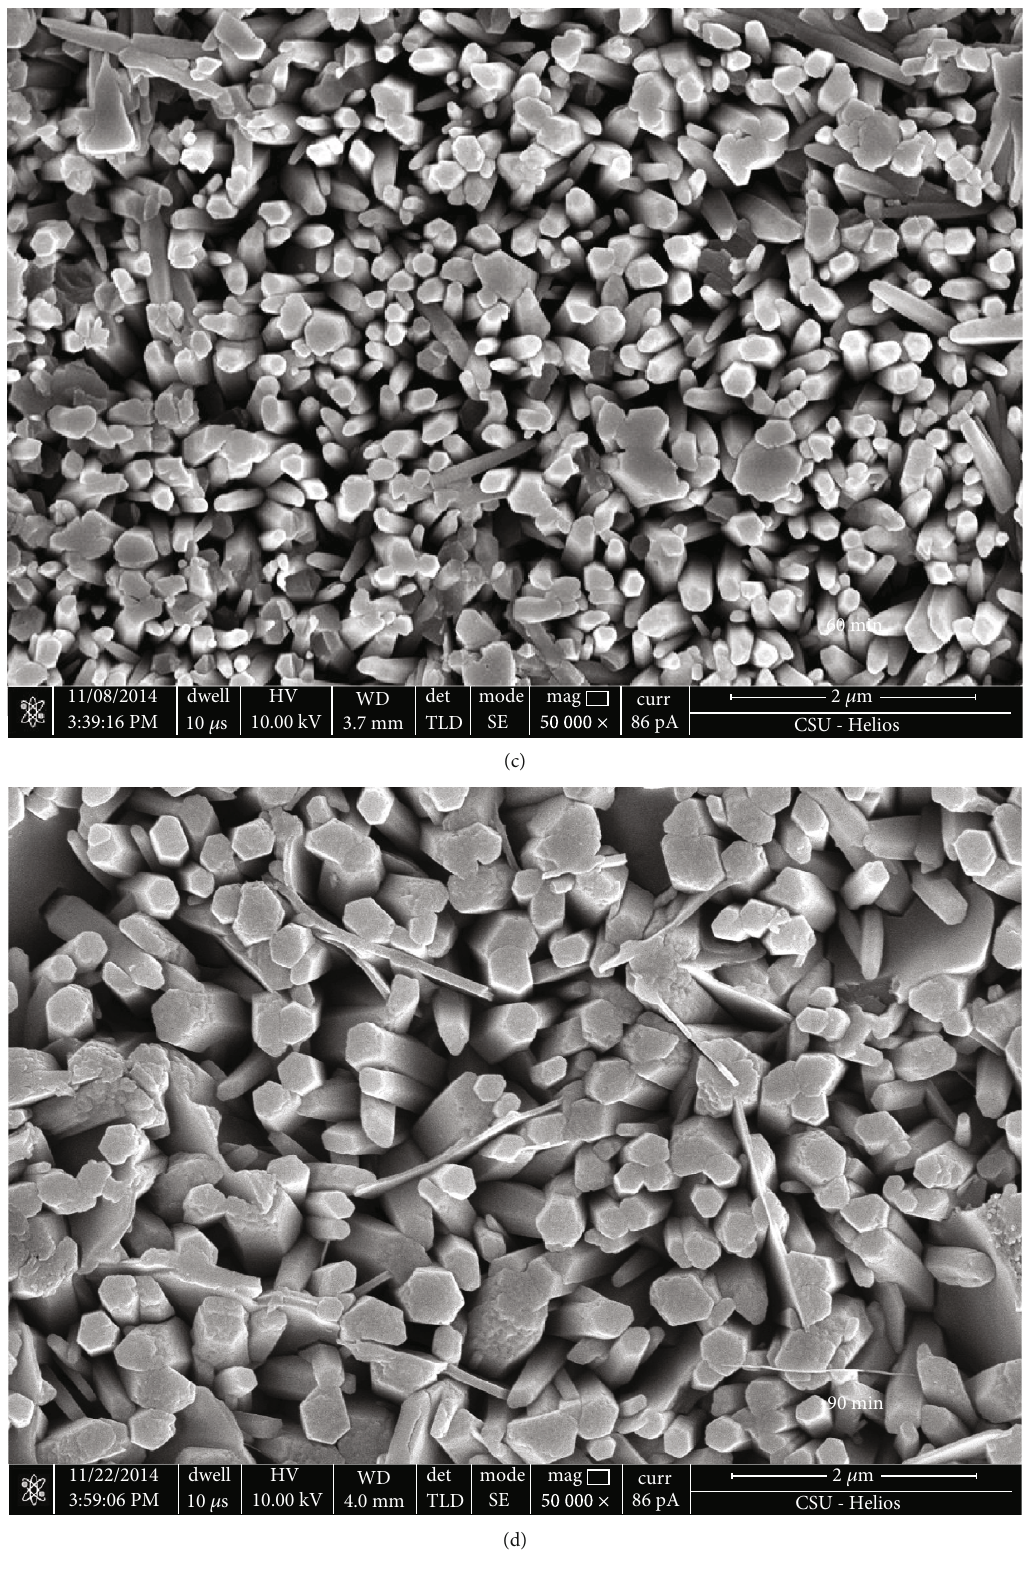
Figure 7: Morphological evolution of Al-doped ZnO NRAs grown by electrodeposition method as a function of deposition time. The deposition parameters: 3mM Zn(NO ) , Al 3+ /Zn 2+ ratio 1 at%, 80 ° C, electrode distance 2 cm, applied potential -1.5V, deposition time: (a) 3 2 10min, (b) 30 min, (c) 60 min, and (d)